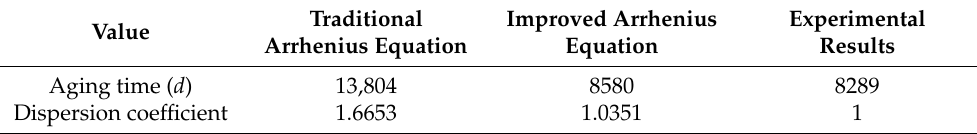
Table 4. Comparison of life prediction results between traditional and improved Arrhenius